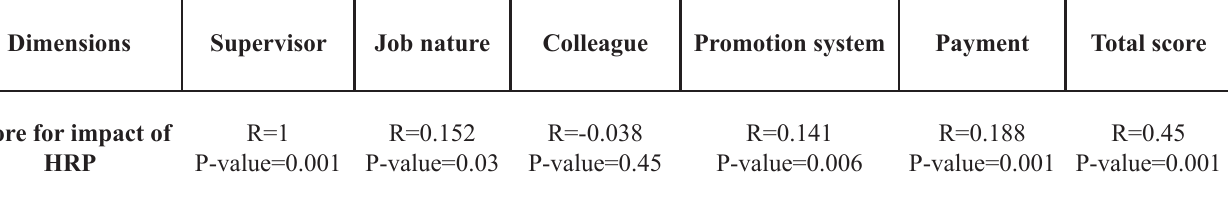
Table 3. Correlation distribution between the dimensions and total scores of job satisfaction and the impact of the HRP Dimensions